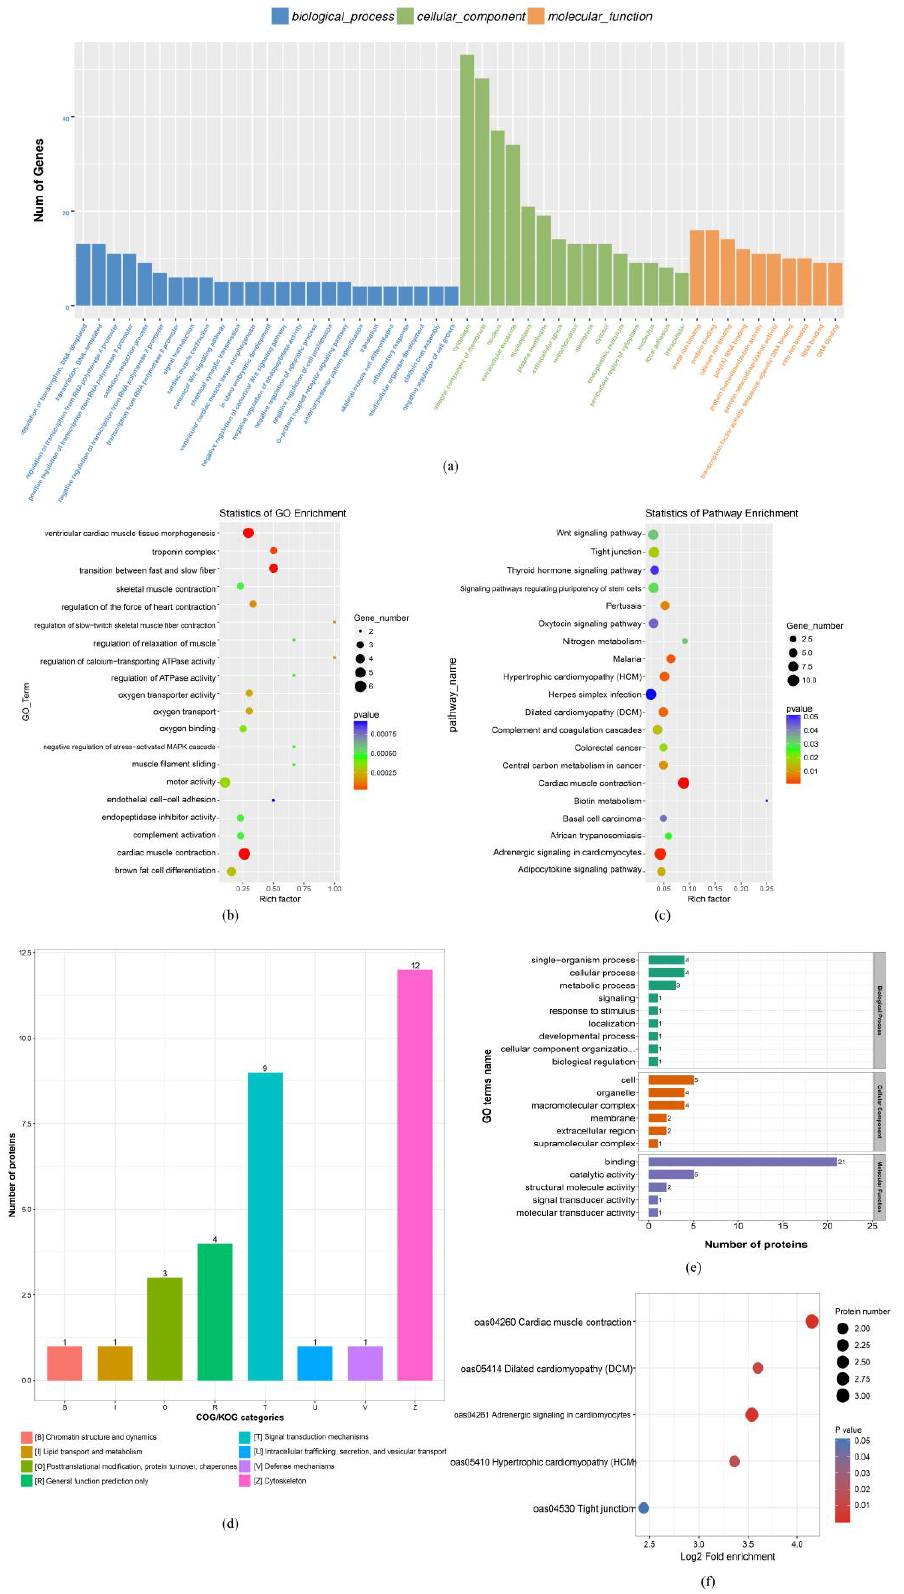
Figure 5. D135T vs. D135N differential expression mRNA and protein enrichment